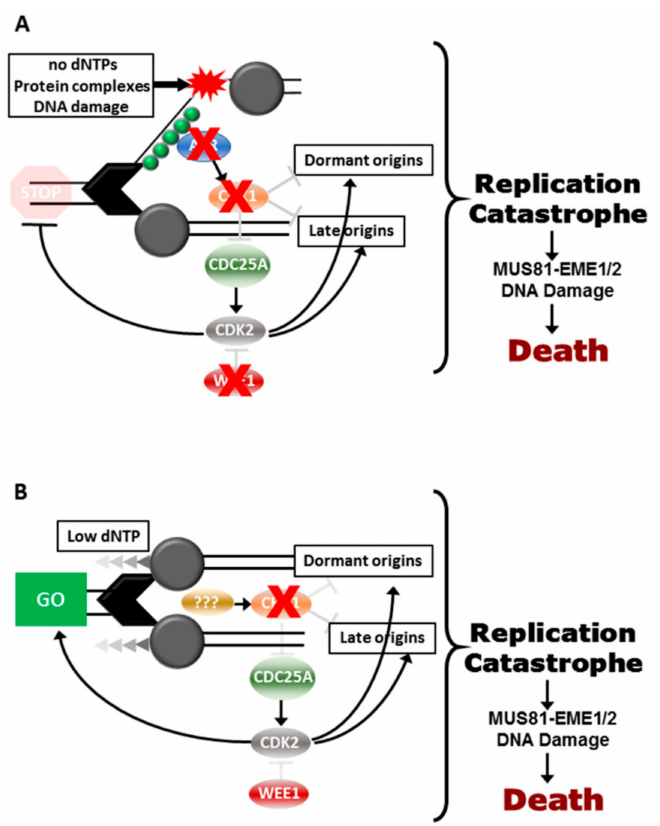
Figure 2. Responses to replication stress. E ff ects of inhibition of ( A ) ATR, CHK1 or WEE1 in cells with high replications tress, or ( B ) to inhibition of CHK1 in cells with moderate replication stress. This combination has not translated in clinical trials where only low response rates were